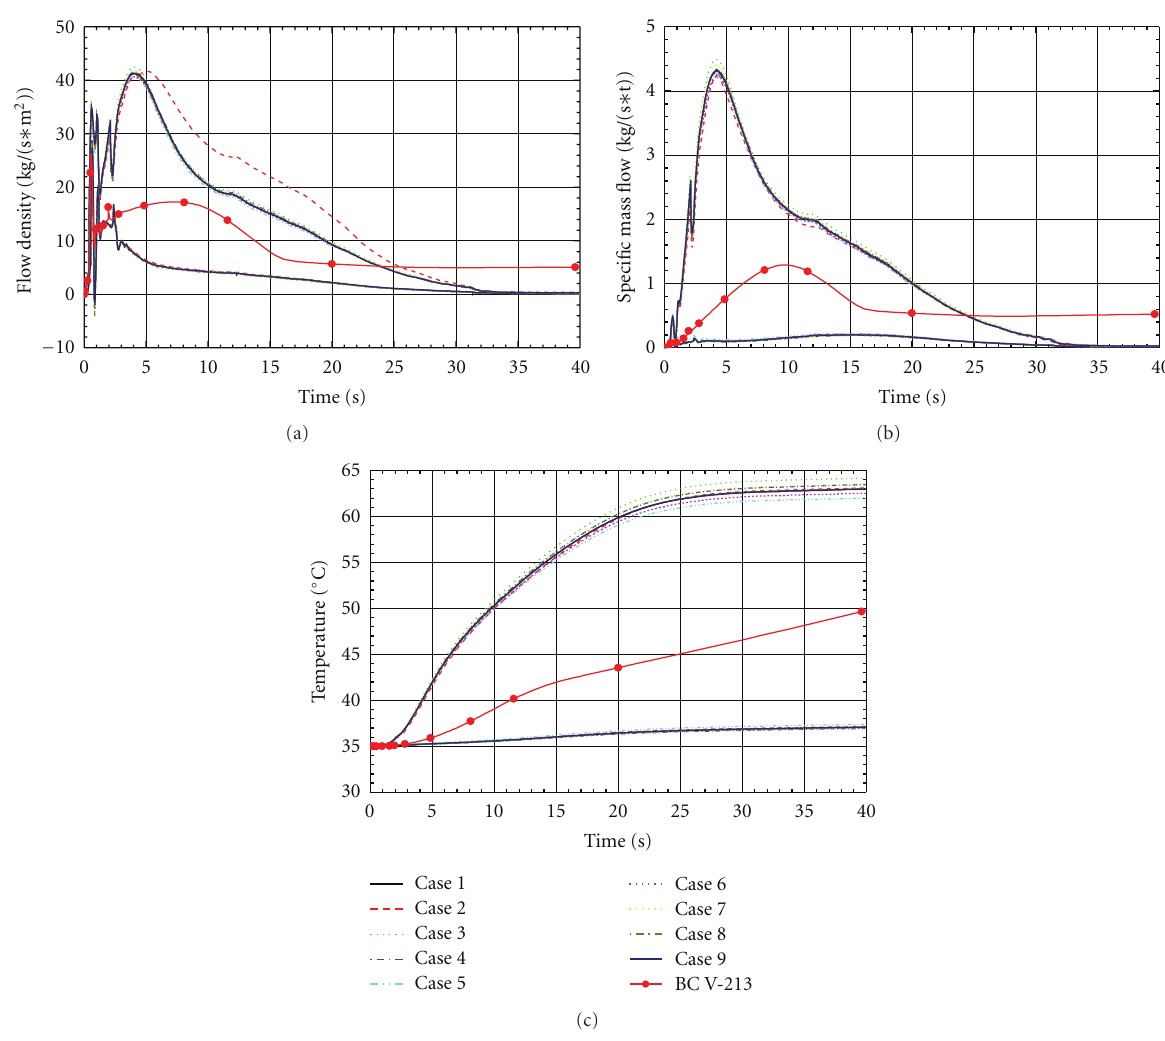
Figure 6: Criteria C1—C3. (a) C1: mass flow density entering BC gap/caps (and NPP bandwidth), (b) C2: specific steam mass flow entering BC water layer (and NPP bandwidth), (c) C3: BC water temperature (and NPP